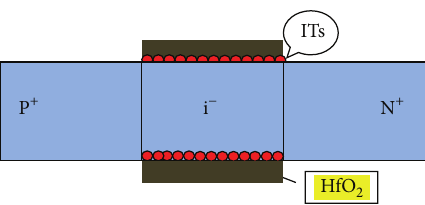
Figure 1: Device structures of n DG-TFET with steep doping profiles.